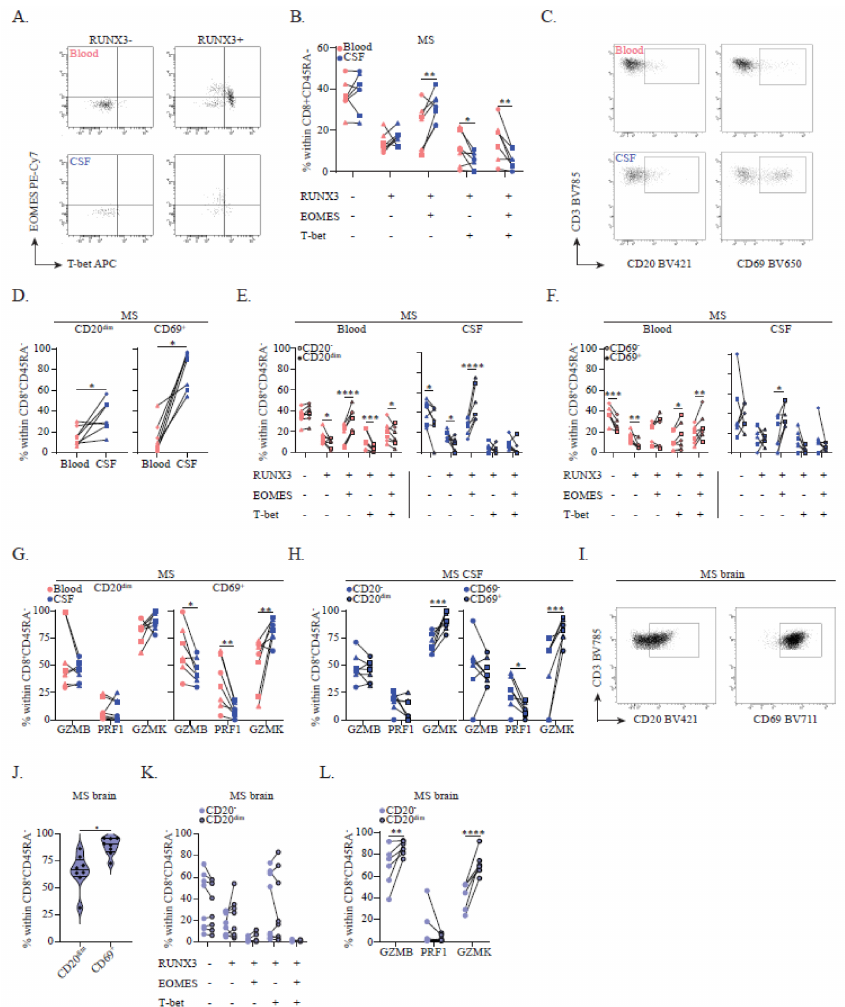
Figure 3. The relation between RUNX3, EOMES and T-bet expression patterns and brain residency- associated marker expression in MS CSF and brain tissue. ( A ) Representative FACS plot showing the distribution of EOMES and T-bet within the RUNX3 − and RUNX3 + CD8 + memory T cell pool in paired early MS blood and CSF and its quantification ( B ) ( n = 7). ( C ) Representative FACS plot showing CD20 and CD69 expression on CD8 + memory T cells in paired early MS blood and CSF. ( D ) Frequencies of CD20 dim and CD69 + cells within the CD8 + memory T cell pool in paired early MS blood and CSF ( n = 7). ( E ) Percentages of paired CD20 − versus CD20 dim and ( F ) CD69 − versus CD69 + cells with RUNX3, EOMES and T-bet (co)expression in the CD8 + memory T cell pool in early MS blood and CSF ( n = 7). ( G ) GZMB, PRF and GZMK expression by CD20 dim and CD69 + CD8 + memory T cells in paired early MS blood and CSF ( n = 7). ( H ) Percentages of GZMB, PRF and GZMK expression by paired CD20 − versus CD20 dim and CD69 − versus CD69 + CD8 + memory T cells in early MS CSF ( n = 7). ( I ) Representative FACS plot showing CD20 and CD69 expression on CD8 + memory T cells in late-stage MS brain tissue and its quantification ( J ) ( n = 8 of 4 brain donors). ( K ) Frequencies of paired CD20 − versus CD20 dim cells with RUNX3, EOMES and T-bet (co)expression in the CD8 + memory T cell pool in late-stage postmortem MS brain tissue ( n = 8 of 4 brain donors). ( L ) GZMB, PRF and GZMK expression by paired CD20 − versus CD20 dim CD8 + memory T cells localized in late-stage postmortem MS brain tissue ( n = 8 of 4 brain donors). Lines represent paired measurements for the same donor. ( B , D – F ) Treatment-naive patients were depicted as circles and patients treated with methylprednisolone or disease-modifying therapy were depicted as squares or triangles, respectively. Data were compared using the Wilcoxon rank-sum test or ( D , J ) two-way ANOVAs with FDR-BKY correction. * p < 0.05, ** p < 0.01, *** p < 0.001 and **** p <